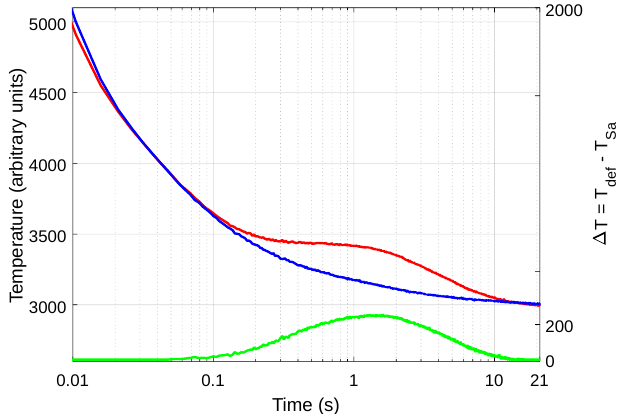
Figure 7. Thermal profiles (temperature vs. time plots on a semi-logarithmic scale) of a pixel inside defect FBH-4M (red plot); a sound pixel close to this defect (blue plot); and the absolute thermal contrast between these two (green plot).